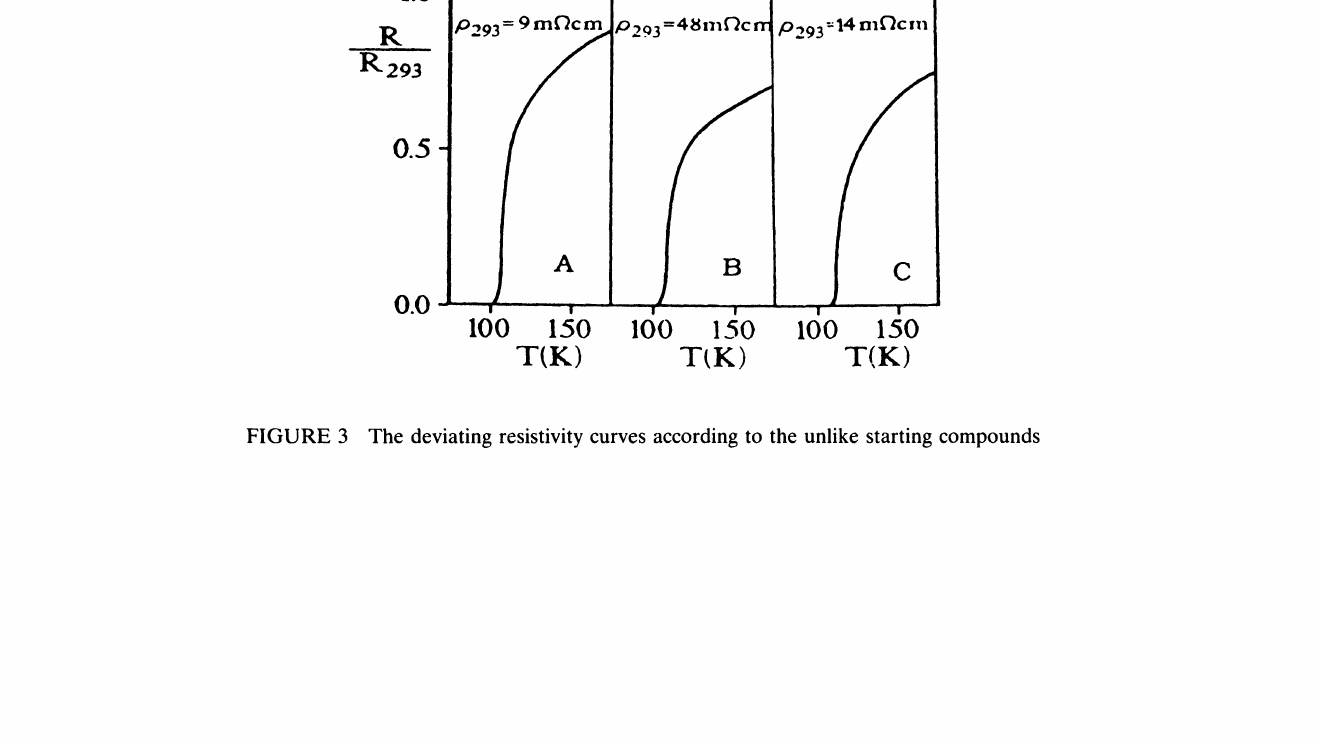
FIGURE 2 Different X-ray diffraction patterns reflecting the difference in preparation temperatures T0 and Tc above 100 K (Fig. 3). However, the values of these pa- rameters vary (see Table 1) depending on the groups of initial materials.